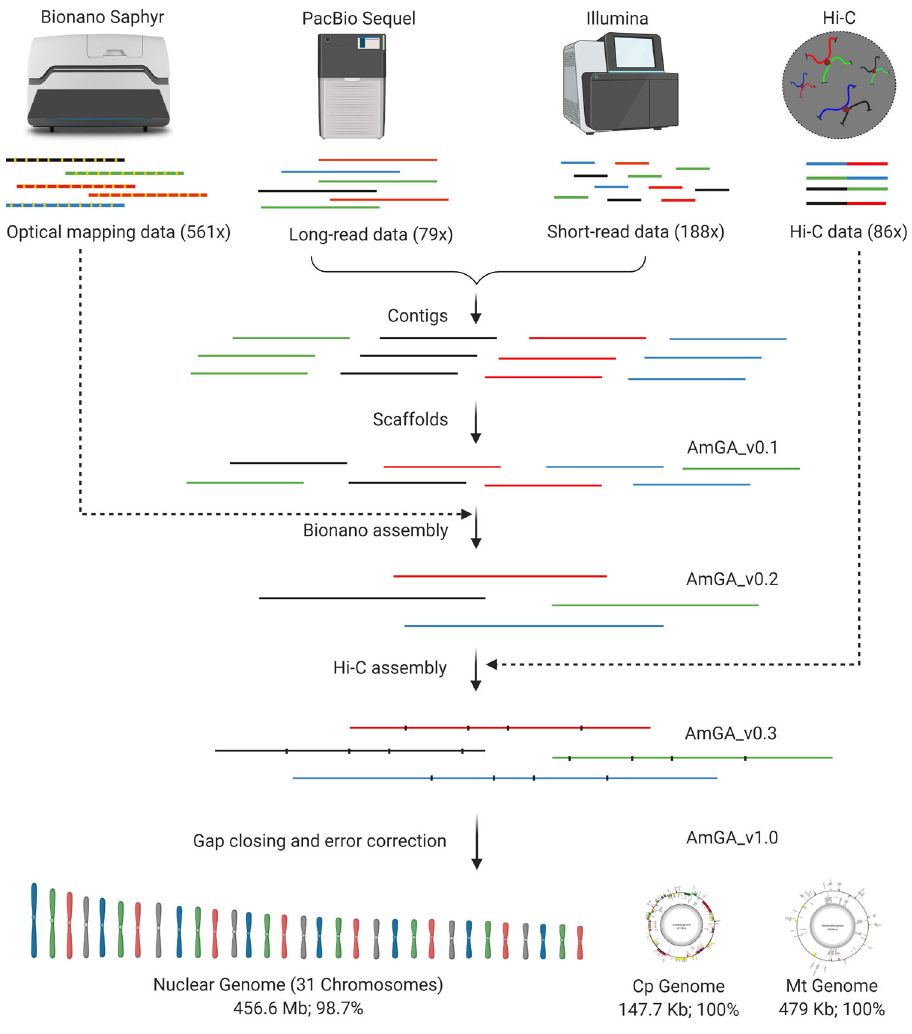
Fig. 2 Schematic of the de novo assembly of A. marina genome. Long-read and short-read data from PacBio Sequel and Illumina, respectively, were subjected to hybrid assembly to build contigs that were combined to build scaffolds. Super-scaffolds were built by combining the scaffolds from Bionano assembly and those from the previous step. Chromosome-scale assembly was built using the Hi-C chromosome conformation capture data, and the assembly was further re fi ned by gap closing and error correction. Sequence data from a scaffold that contained the organellar genomes were re-assembled to build full-length circular chloroplast and mitochondrial genomes. Table 1 A. marina genome assembly